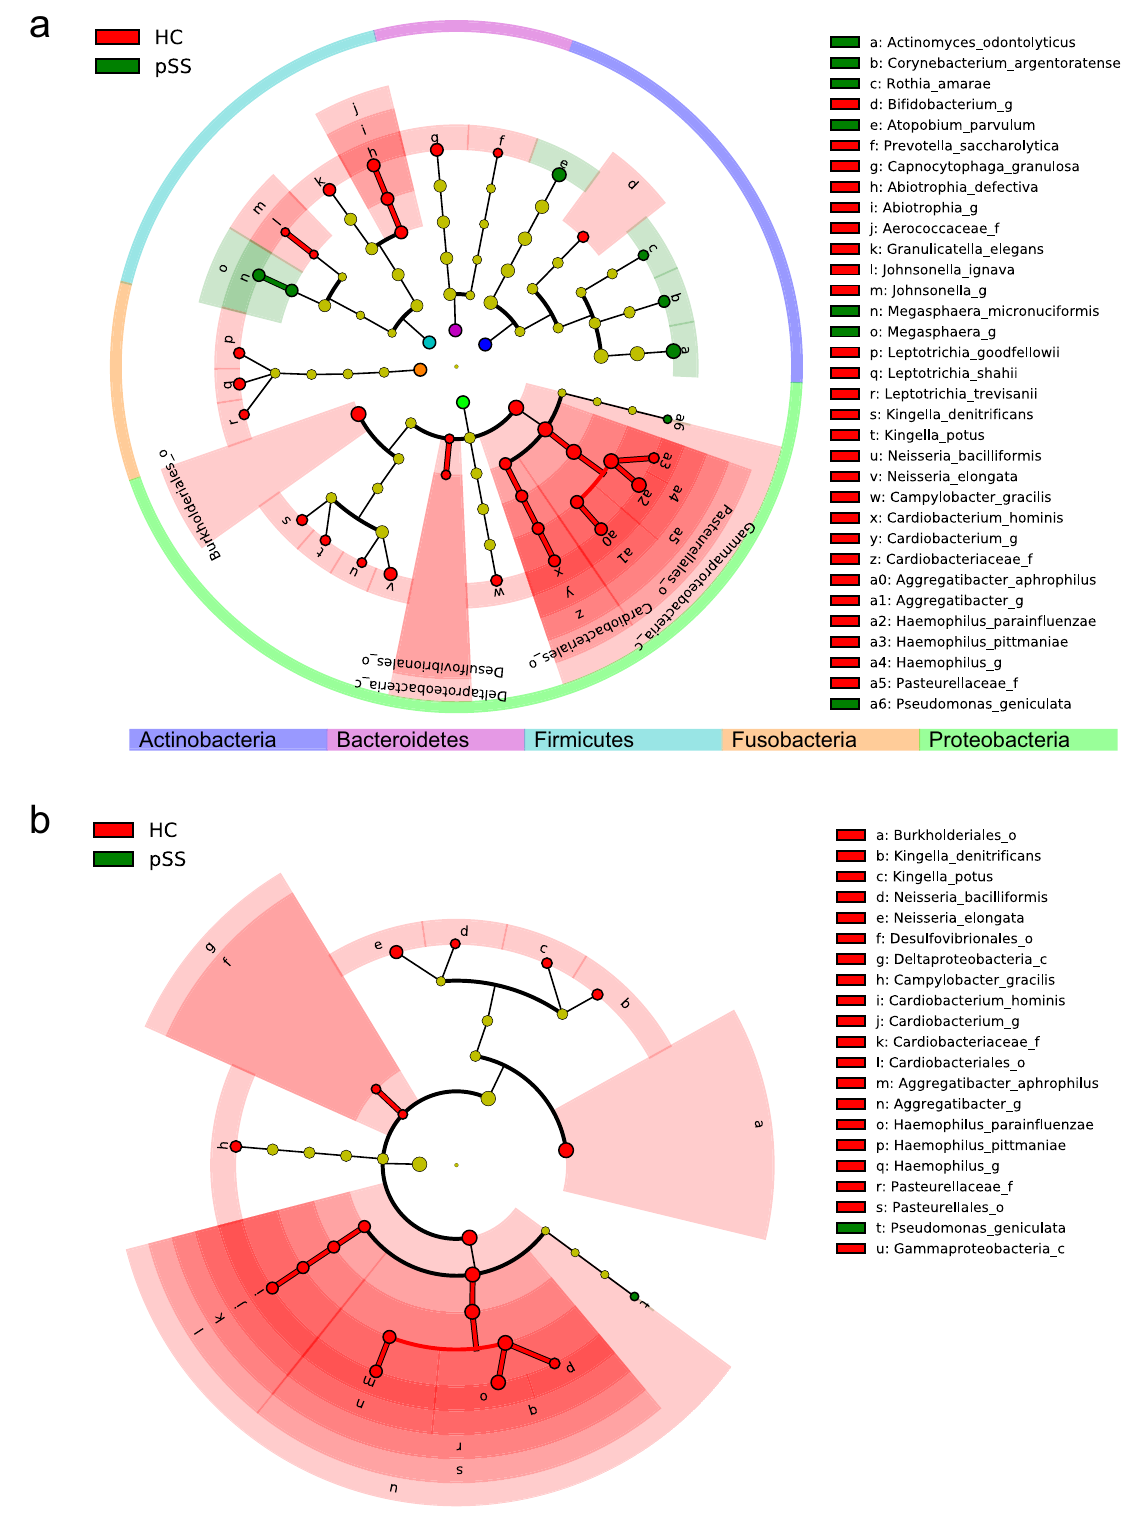
Fig. 2 Cladogram of differentially abundant salivary microbiota between primary Sjögren ’ s syndrome patients and healthy controls by linear discriminant analysis effect size (LEfSe). Green nodes represent taxa enriched in pSS patients ( “ pSS ” ), while red nodes denote those enriched in healthy controls ( “ HC ” ). “ p ” , “ c ” , “ o ” , “ f ” , and “ g ” stand for phylum, class, order, family, and genus, respectively. From inside out, circles depict phylum, class, order, family, genus, and species, respectively. Only taxa of the fi nal set (refer to Supplementary Table 1) or taxa of higher ranks related to the fi nal set are presented a within all phyla and each phylum labeled with a differently colored ribbon, and b within the phylum Proteobacteria